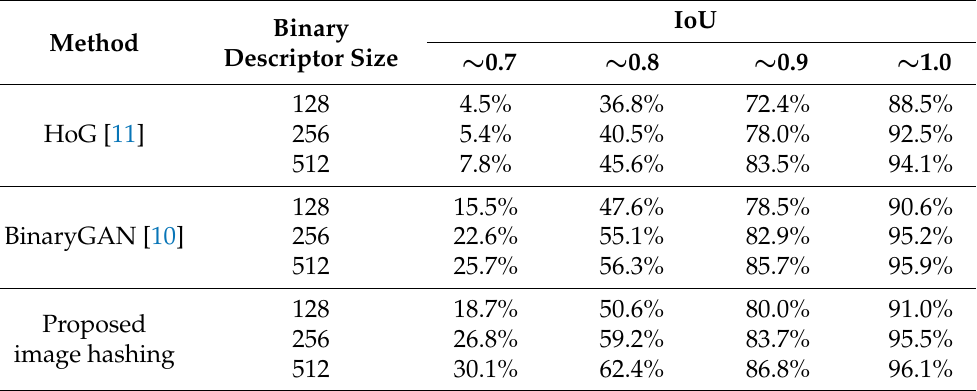
Table 2. Identification results on the copyright image dataset by applying the HoG, the BinaryGAN and the proposed method with geometric manipulation and binary descriptor sizes.